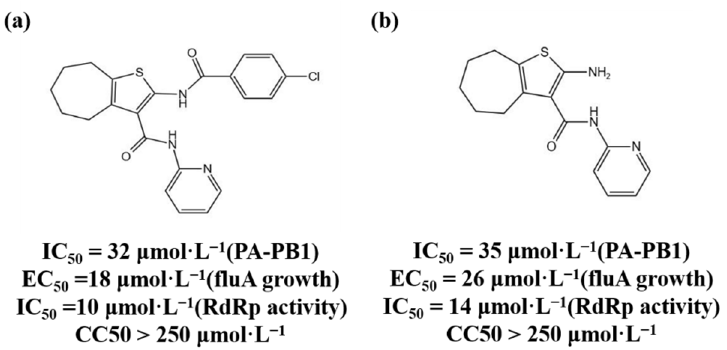
Figure 1. ( a,b ) Chemical structures of Protein–protein interaction inhibitors and their antiviral